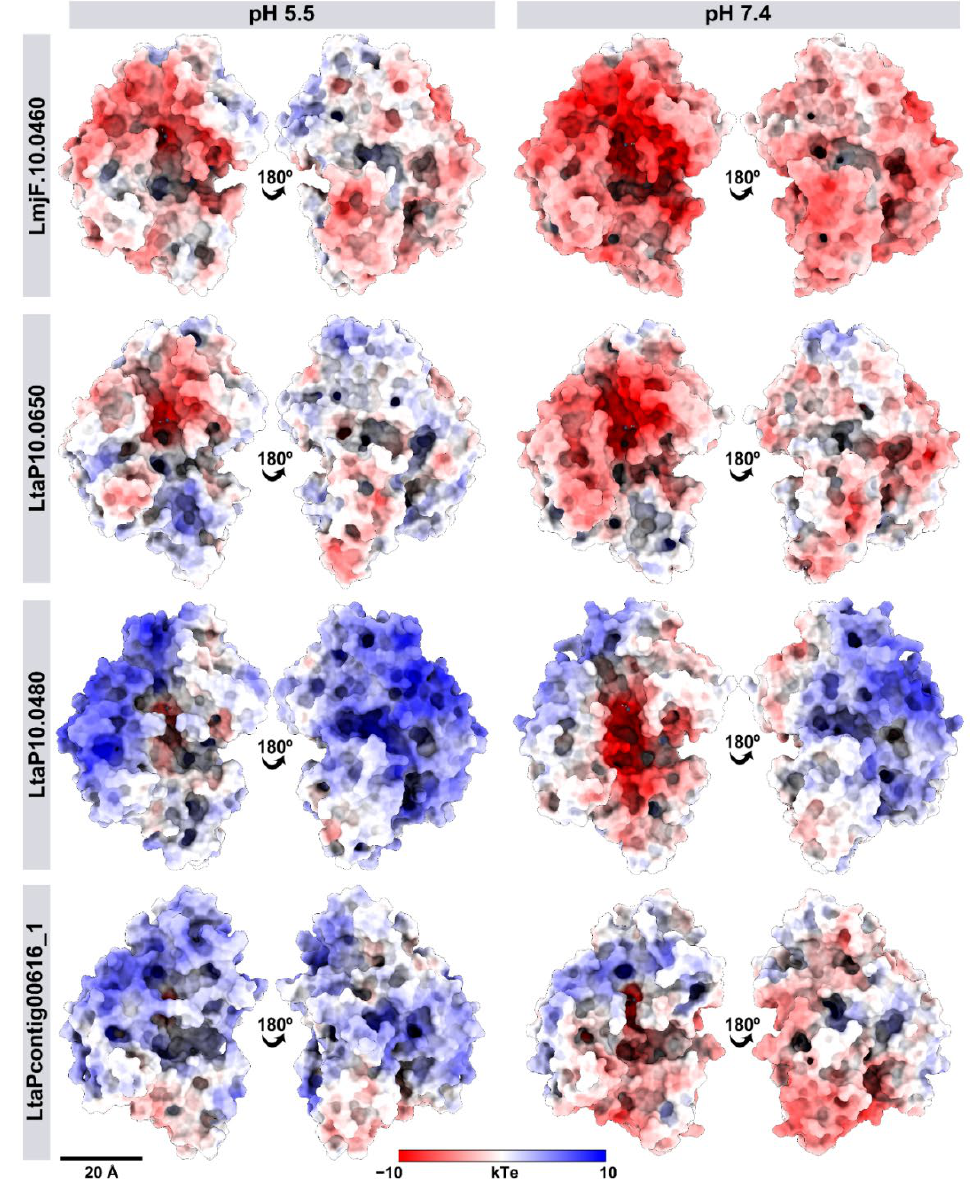
Figure 3. Differences in the surface electrostatic potential of L. tarentolae and L. major leishmanolysins. The comparative molecular dynamic analysis was performed using the crystal structure of L. major LmjF.10.0460 (PDBid: 1LML) and the modeled L. tarentolae LtaP10.0480, LtaP10.0650 , and LtaPcontig00616_1 in pH 5.5 and 7.4. The molecular surface is colored according to electrostatic potential using the Chimera software, where red, white, and blue correspond to acidic, neutral, and basic potentials, respectively.